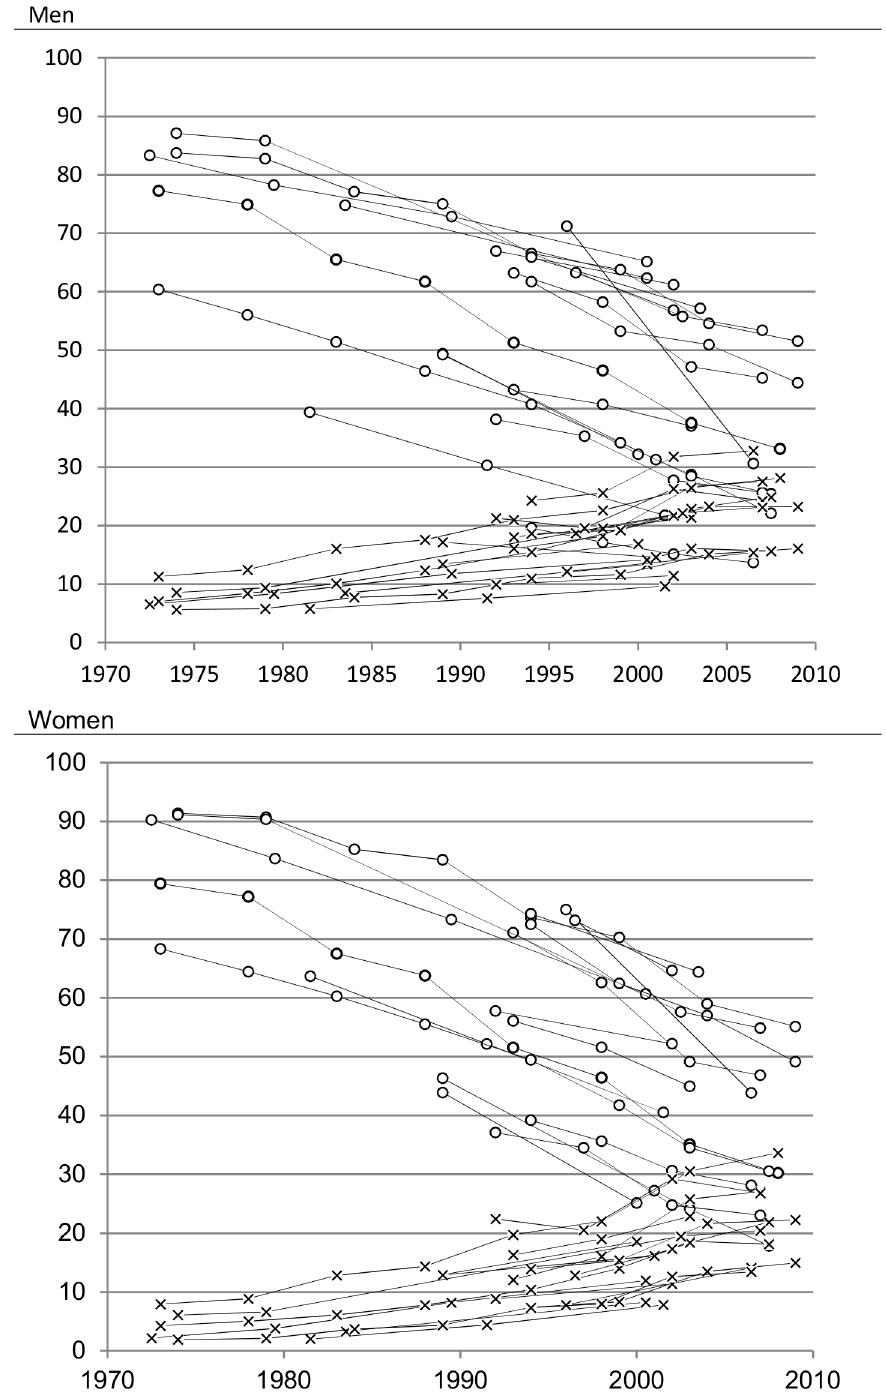
Fig 2. Observed averageproportions of high and low educated by median year among men and women. Each data point represents one combination of populationand period. Age standardized using the observedgenderspecific age distribution in the